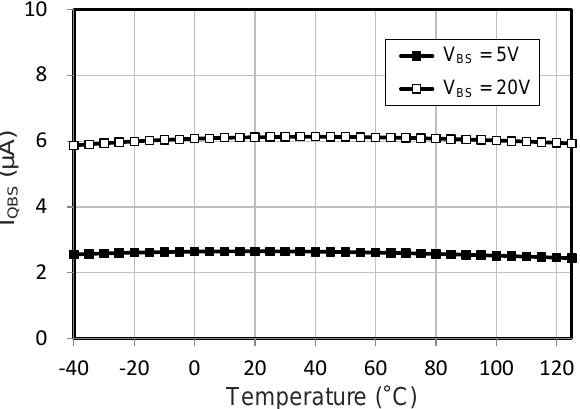
Figure 10. Quiescent current consumption of proposed high-side UVLO circuit at temperature variation.